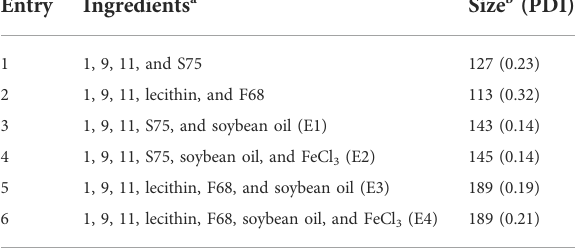
TABLE 1 Ingredients, particle sizes, and PDIs of partially fl uorinated